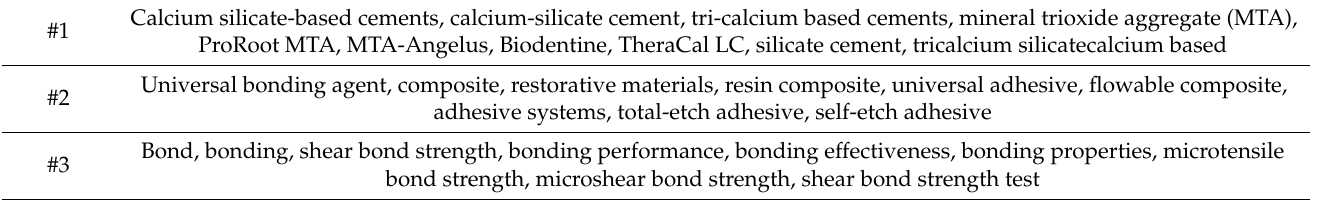
Table 3. Keywords used in search